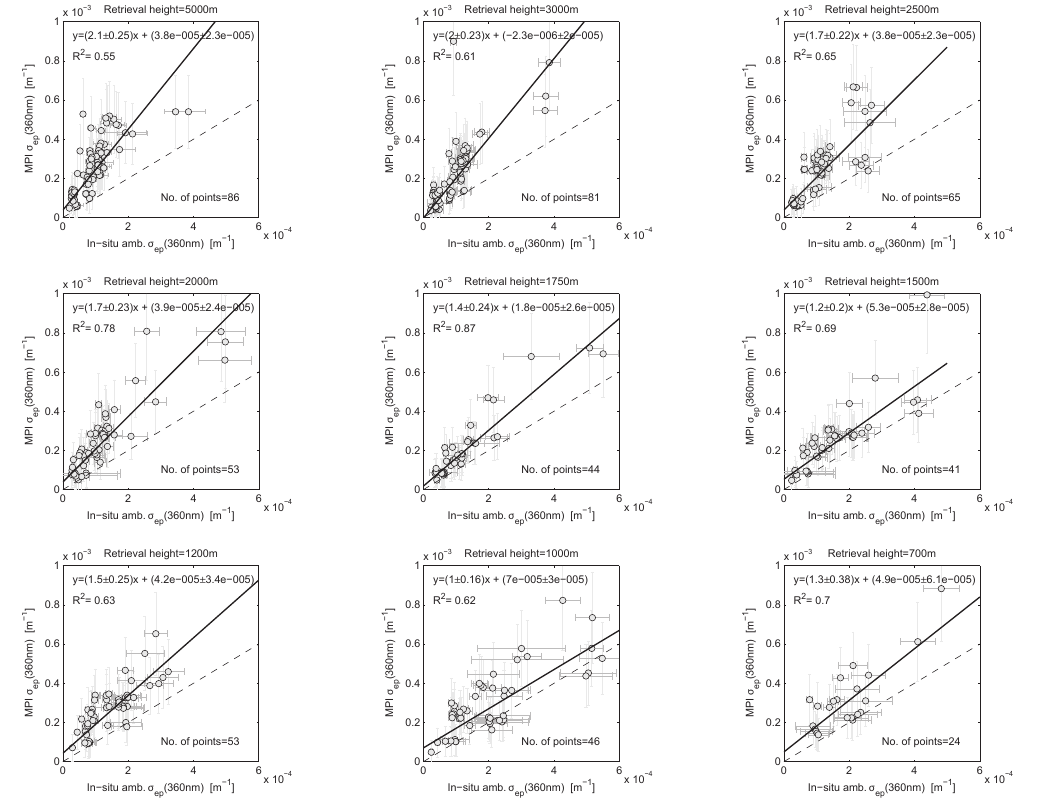
Fig. 10. Ambient extinction coefficient measured by the MPI MAX-DOAS instrument, where the layer height is kept variable during the MAX-DOAS retrieval vs. in-situ. The aerosol type is assumed to be constant within the layer (for the calculation of the in-situ σ ep , only the RH changes with height). The RH profiles are taken from assimilated COSMO data. Solid line represents a bivariate linear regression including weights (with calculated uncertainty of slope and intercept), dashed line is the